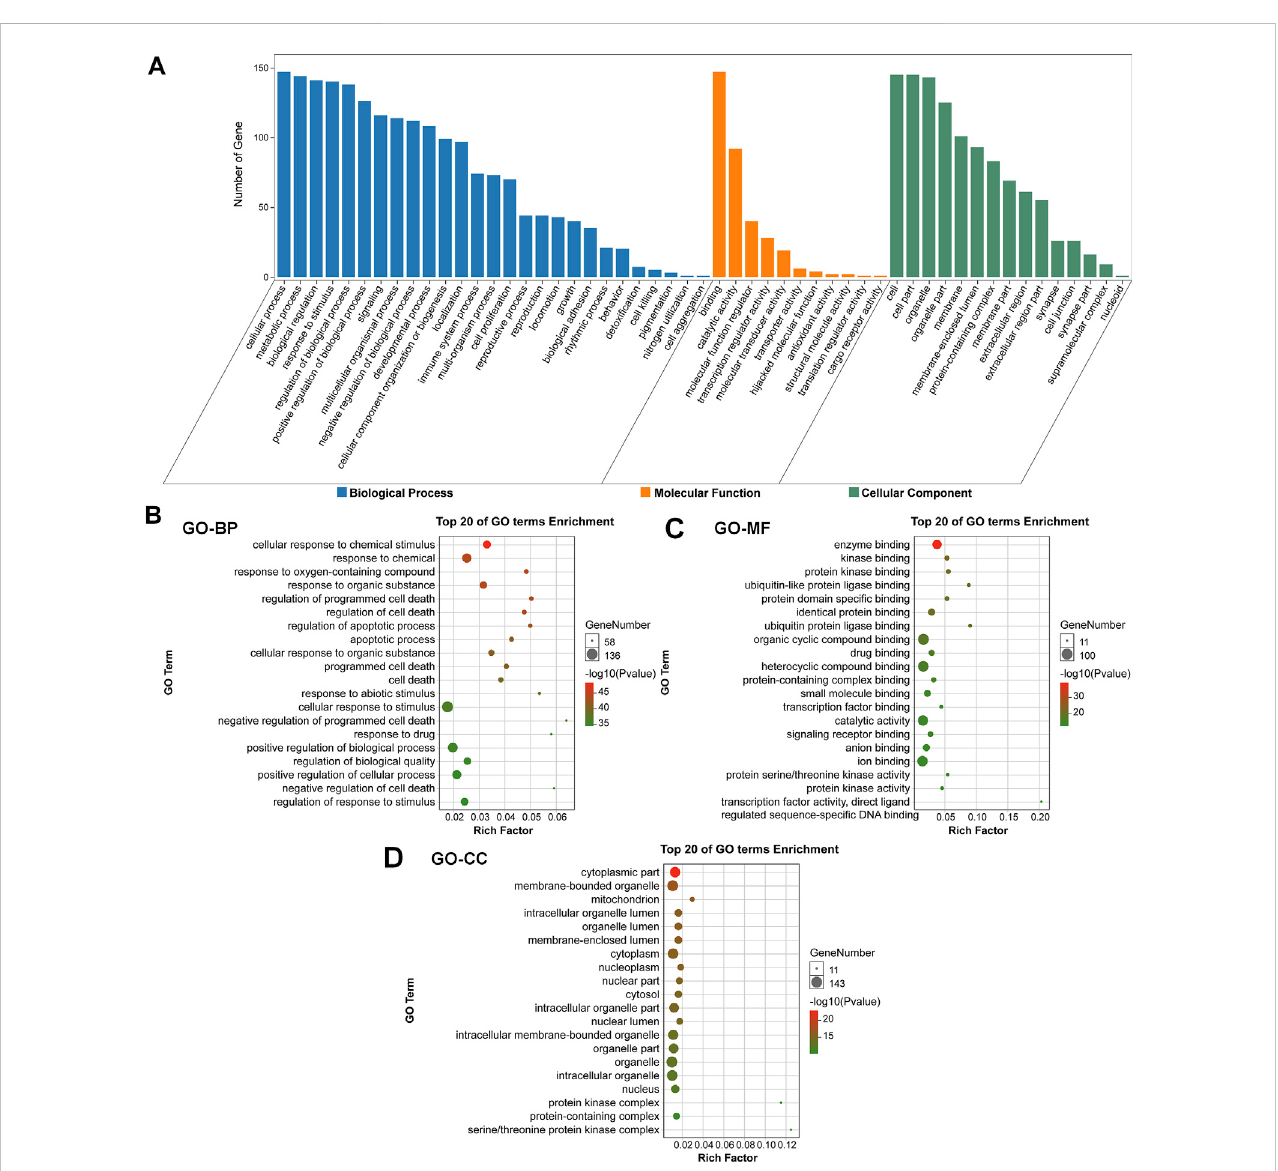
FIGURE 3 GO enrichment analysis of the key targets of FMNT and CS against colon cancer (A) The number of genes involved in the biological process (BP), molecular function (MF) and cellular component (CC) (B) GO-BP enrichment analysis of the 147 key targets (C) GO-MF enrichment analysis of the 147 key targets (D) GO-CC enrichment analysis of the 147 key targets. The top 20 enriched GO terms are displayed, and only terms with p < 0.05 were selected for